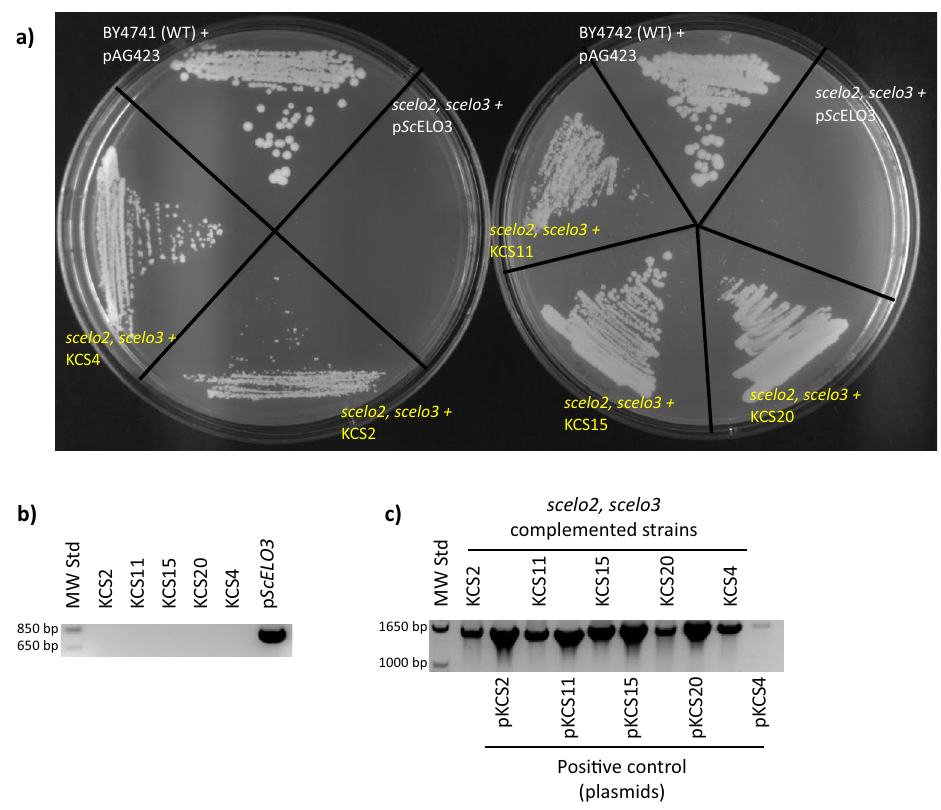
Figure 1. ZmKCS -expressing strains complement the lethality of the scelo2; scelo3 double mutant. Out of the 26 Zm KCSs evaluated, the expression of five Zm KCS isozymes were able to restore the viability of the synthetically lethal phenotype of the scelo2; scelo3 double mutant strain. ( a ) Growth of the indicated strains on SD his- media containing 5-FOA; controls include the WT BY4741 and BY4742 strains harboring the empty pAG423-GPD vector, and the scelo2; scelo3 double mutant strain whose viability was maintained by the ectopic expression of ScELO3 . ( b ) PCR molecular confirmation of the absence of the ectopic ScELO3 gene in the recovered Zm KCS complemented strains. Template DNA was amplified with the ScELO3 -specific primers (5 ′ -GCC GAC CAG TTC CAG TCT TT and 5 ′ -CCG TCC AAG TAT TTG TGA GC). ( c ) PCR molecular confirmation for the presence of